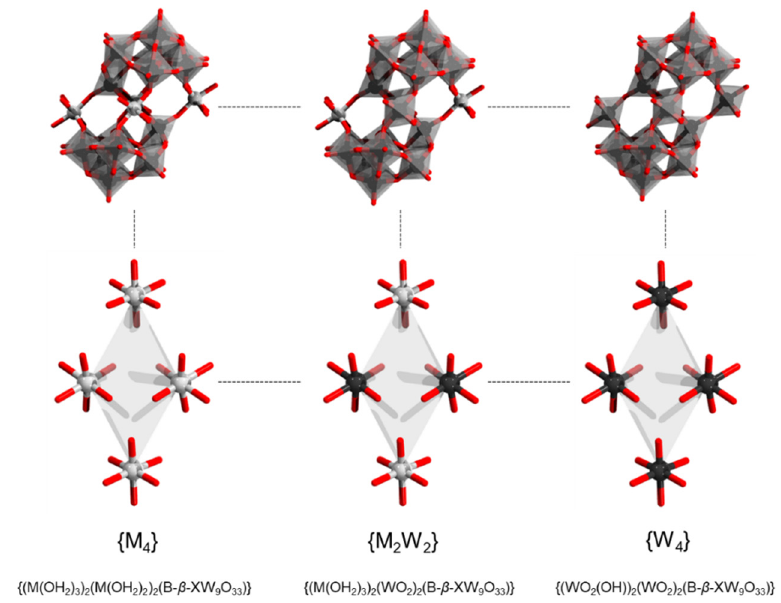
Figure 15. Offset/Krebs-type sandwich archetype ( top row ) and its sandwiched core ( bottom ) depicting full substitution with heterometals ( left ), partial substitution {M 2 W 2 } ( center ) and fully substitution with tungstate addenda {W 4 } units ( right ). Color code: Sb = brown (but covered), M = gray, {MO 6 }/{WO 6 } = gray octahedra, W = black, and O = red. H atoms on aqua ligands are omitted.